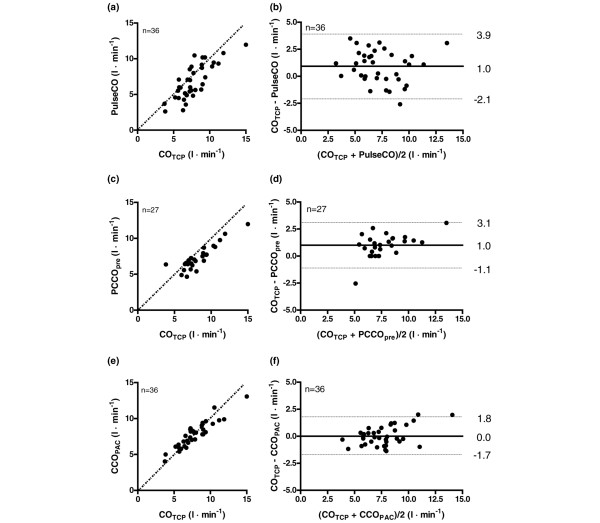
Scatter plots and Bland–Altman plots of pooled data pairs. Scatter plots (left-hand side) and Bland–Altman plots (right-hand side) of pooled data pairs between (a) and (b) bolus transcardiopulmonary thermodilution cardiac output (COTCP) and continuous cardiac output by pulse power analysis (PulseCO; LiDCO system), (c) and (d) between COTCP and continuous cardiac output by pulse contour analysis before recalibration (PCCOpre; PiCCO system), and (e) and (f) between COTCP and continuous cardiac output by pulmonary artery catheter thermodilution (CCOPAC). (a), (c), (e) Scatter plots include line of identity (dotted line). (b), (d), (f) Bland–Altman plots include bias (solid lines) and limits of agreement (dotted lines).